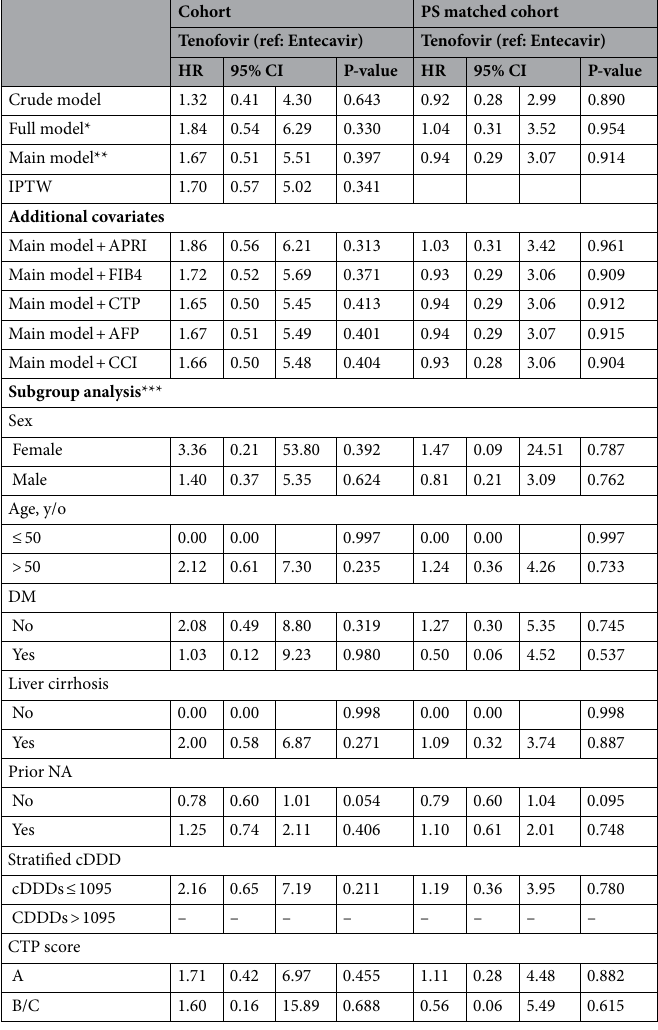
Table 4. HR for ICC. PS propensity score, HR hazard ratio, CT confidence interval, IPTW inverse probability treatment weighting, APRI AST to platelet ratio index, FIB-4 fibrosis index based on 4 factors, CTP Child– Turcotte–Pugh, AFP alpha-fetoprotein, CCI Charlson comorbidity index, DM diabetes mellitus. *Full model is adjusted for age, sex, liver cirrhosis, DM, APRI, FIB4, CCI, CTP, AST, ALT, platelet, AFP, albumin, bilirubin and INR. **Main model is adjusted for age, sex, liver cirrhosis, DM. ***HRs were estimated by fitting the main